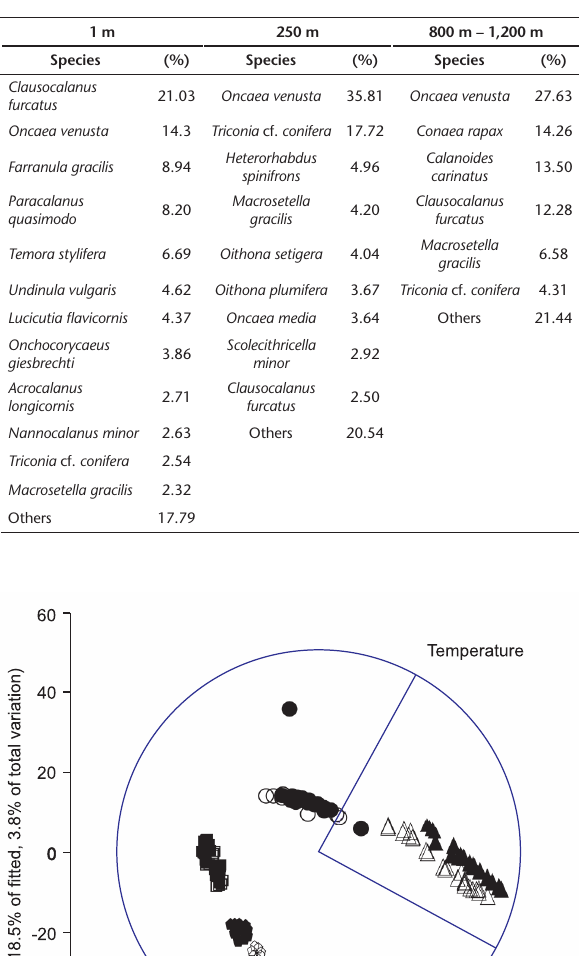
Table 5. Copepod species and their contribution (%) to the simi- larity of assemblages obtained during the dry season through the SIMPER analysis.